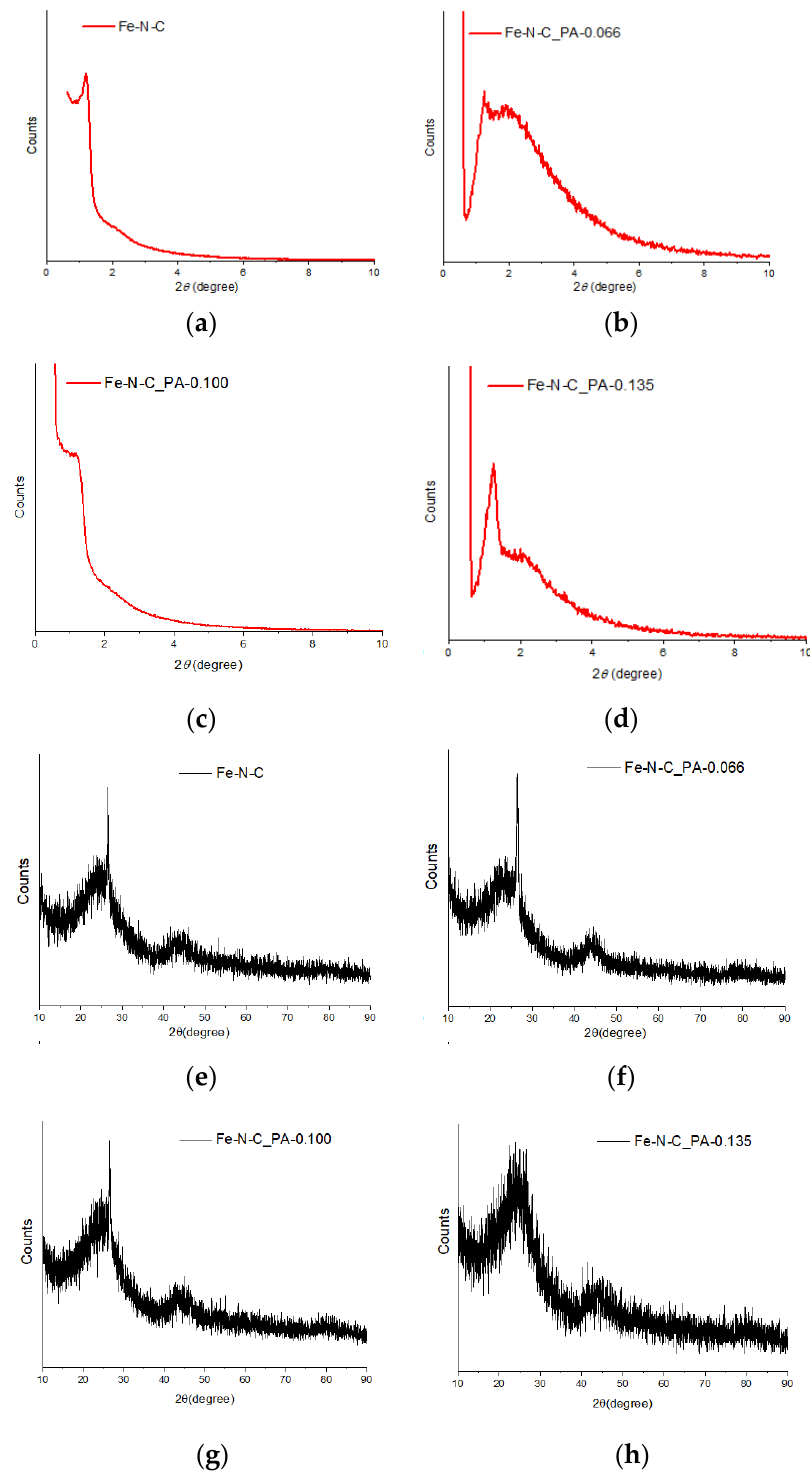
Figure 3. X-ray diffraction patterns of ( a , e ) pristine Fe-N-C, ( b , f ) Fe-N-C_PA-0.066, ( c , g ) Fe-N-C_PA-0.100, and ( d , h) Fe-N_PA-0.135.